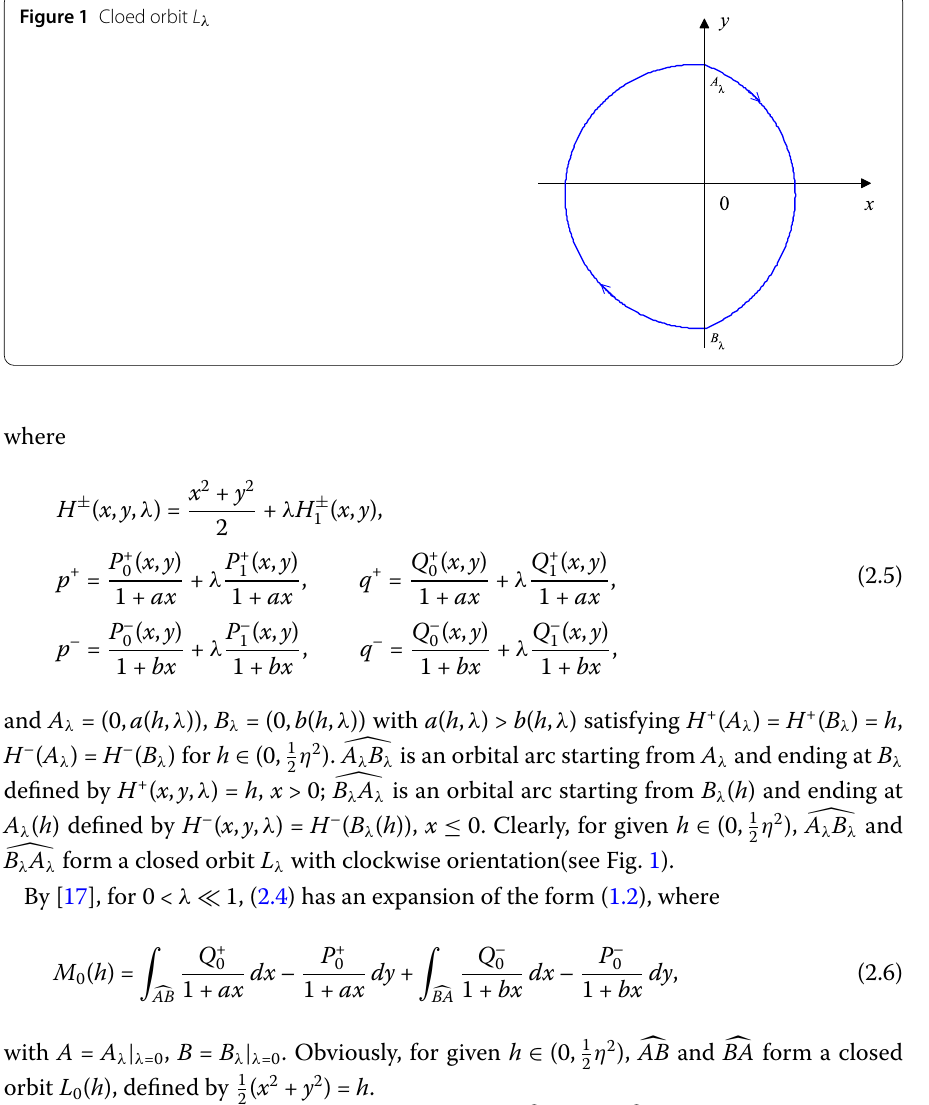
Figure 1 Cloed orbit L